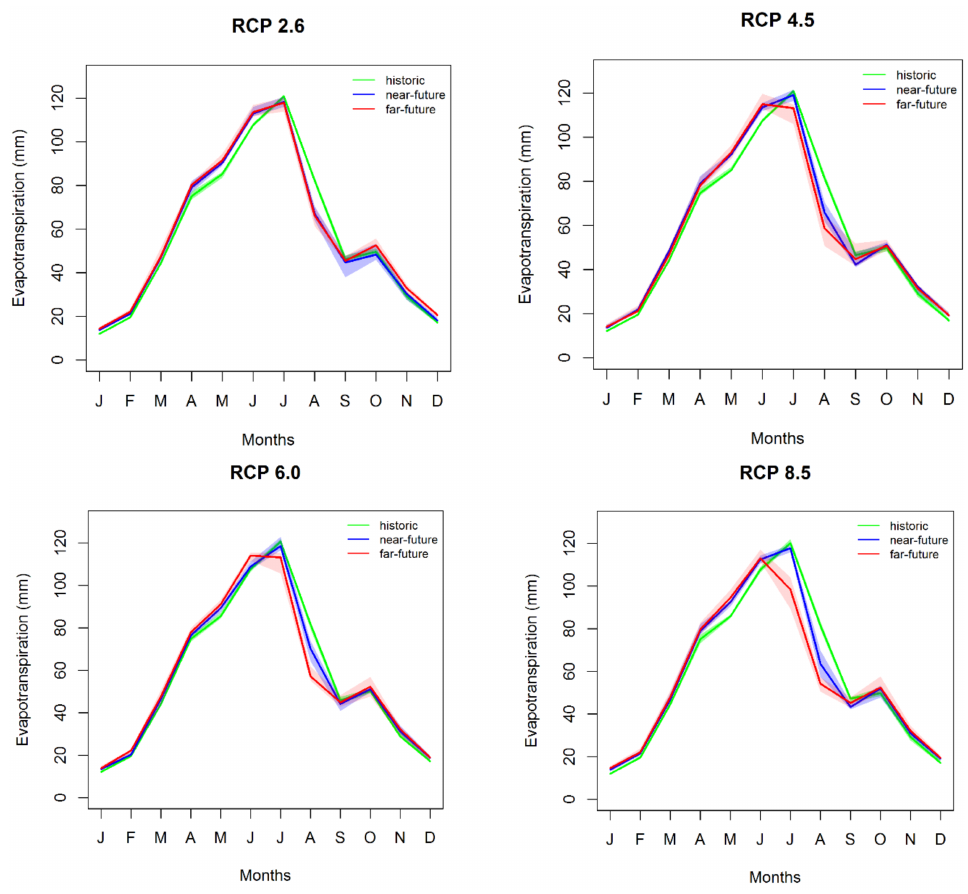
Figure 11. Monthly ensemble median and quartile of downscaled monthly evapotranspiration for historic and future projections in Goodwater Creek Experimental Watershed. The median is represented by the solid line with Q1 represented by the lower bound of the shaded region and Q3, represented by the upper bound of the shaded